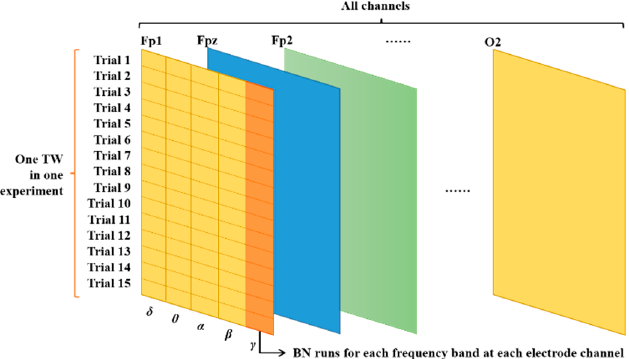
Figure 3. The protocol of ELBN.